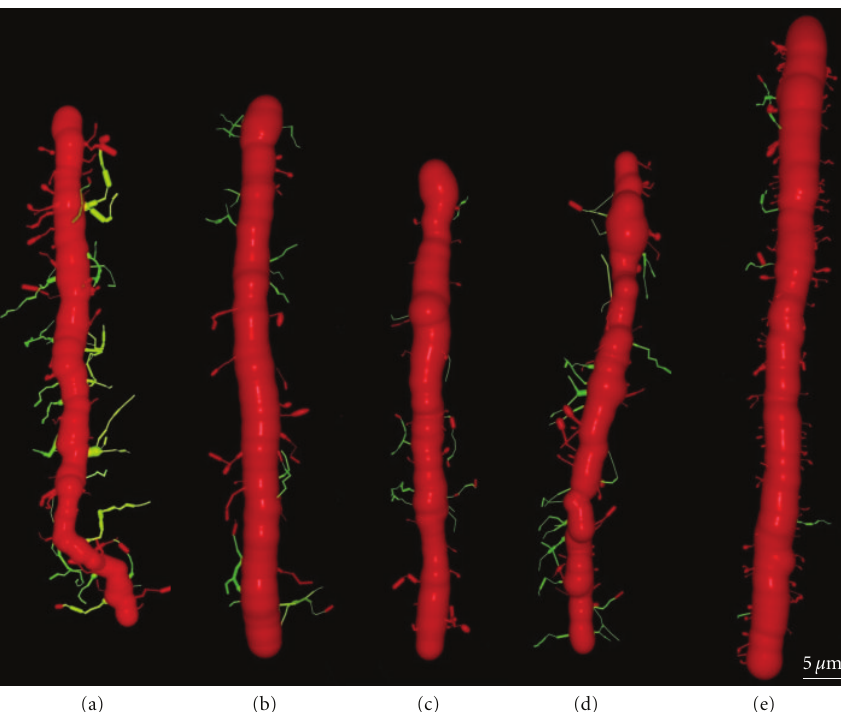
Figure 17: The figure depicts three-dimensional reconstructions showing the development of the apical trunk, layer V pyramidal cells, visual cortex, cat, Cajal histological preparations, Golgi-method. (a) Newborn cat. (b) 9-day-old cat. (c) 20-day-old cat. (d, e) one-month-old cat. Filopodia and protospines are color coded in green, and their number decreases with the animal